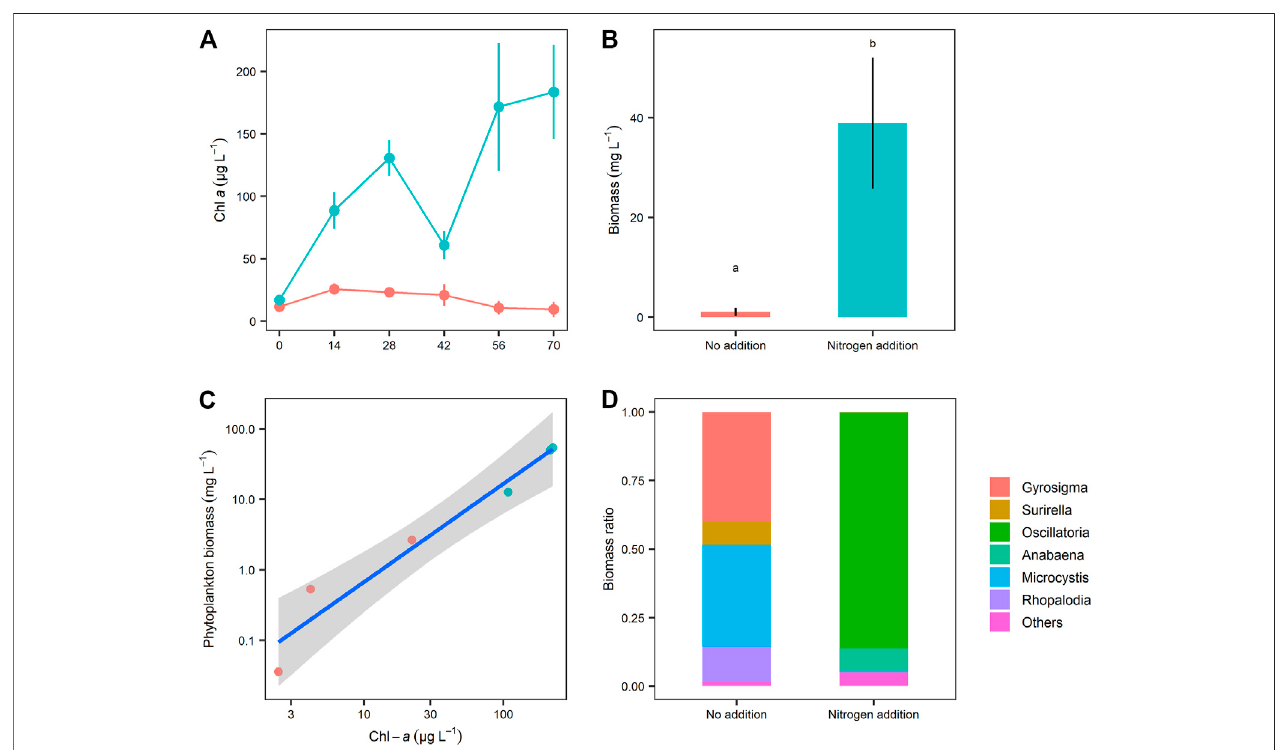
FIGURE 4 | Comparison of (A) temporal changes of chlorophyll a (Chl a ) and (B) phytoplankton biomass at the end of experiment between the two nitrogen treatments, (C) the relationship between Chl a and phytoplankton biomass (both variables were log 10 transformed. Linear model: R 2 (cid:2) 0.95, p < 0.001), and (D) phytoplankton communities at the end of experiment. Values represent mean ± SE ( n (cid:2) 3).